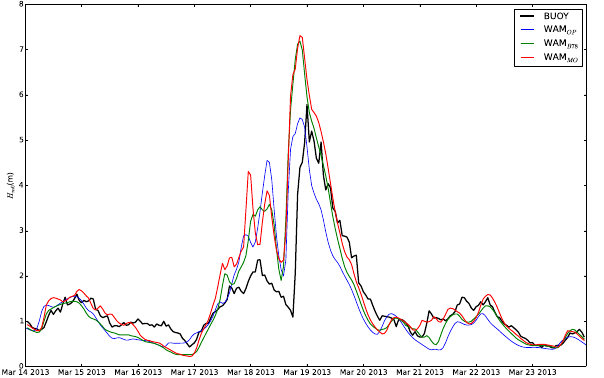
Table 2. Statistics for the La Spezia forecast